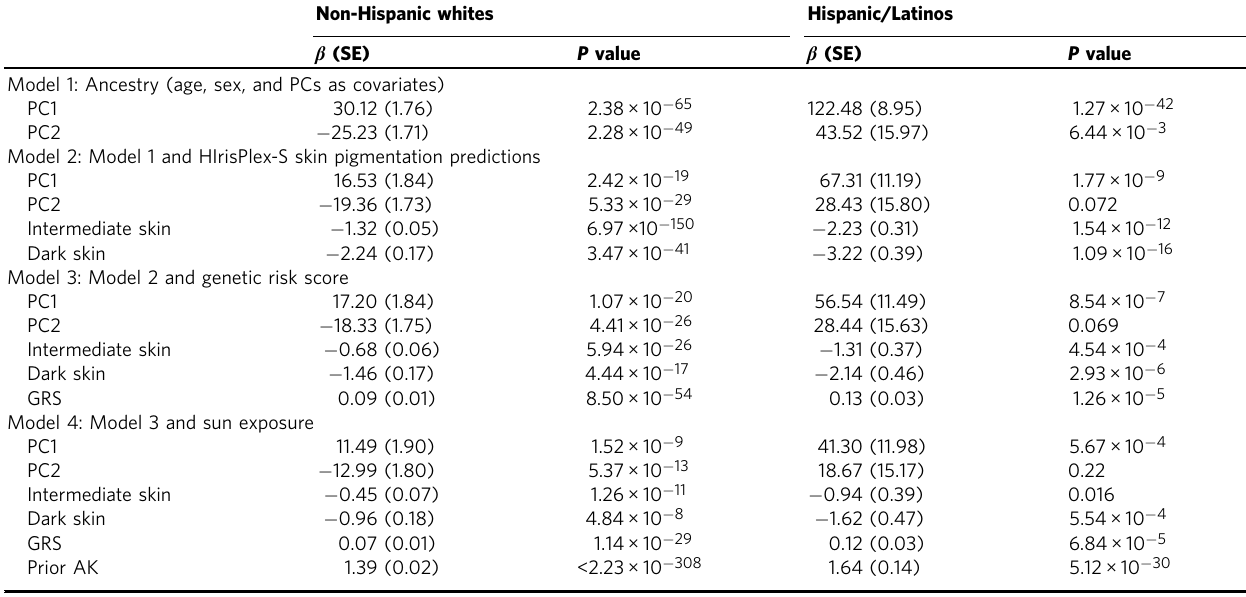
P = 2.42 × 10 − 19 for PC1 and β = − 19.36, P = 5.33 × 10 − 29 for PC2 in non-Hispanic whites) (Table 2 and Supplementary Tables 1 and 2). Within Hispanic/Latino, dark/dark to black skin color showed strong variations in prevalence by geographic ancestry. Within non-Hispanic whites, we also observed variation in skin pigment by geographic ancestry, with lighter skin more prevalent in the northwest of Europe and dark skin more prevalent in the southeast of Europe (Supplementary Figs. 1 and 2).